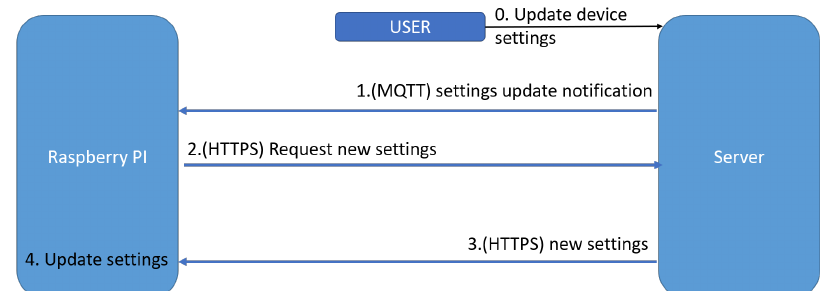
Figure 6. This schema represents the process of updating the settings for a